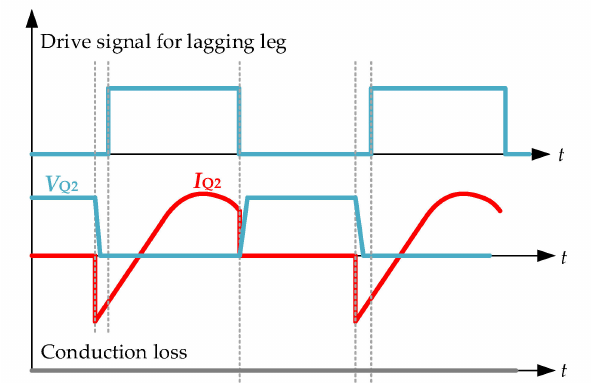
Figure 10. Key waveforms of Q 2 under ZVS conduction.